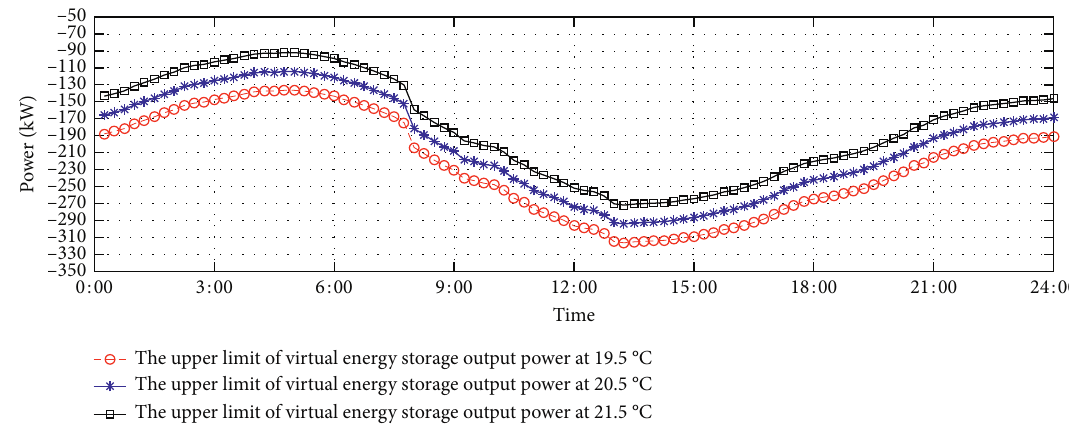
Figure 16: Comparison of the maximum output power of virtual energy storage at different set temperatures.